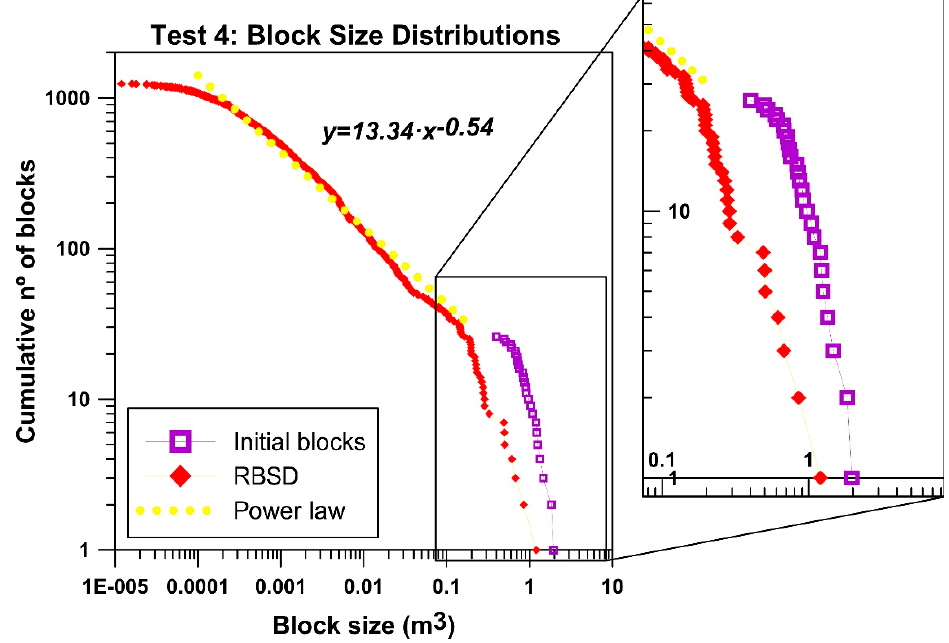
Figure 14. Initial block size distribution (purple) and Rockfall Block Size Distribution (RBSD, all the fragments measured together) obtained in test 4.